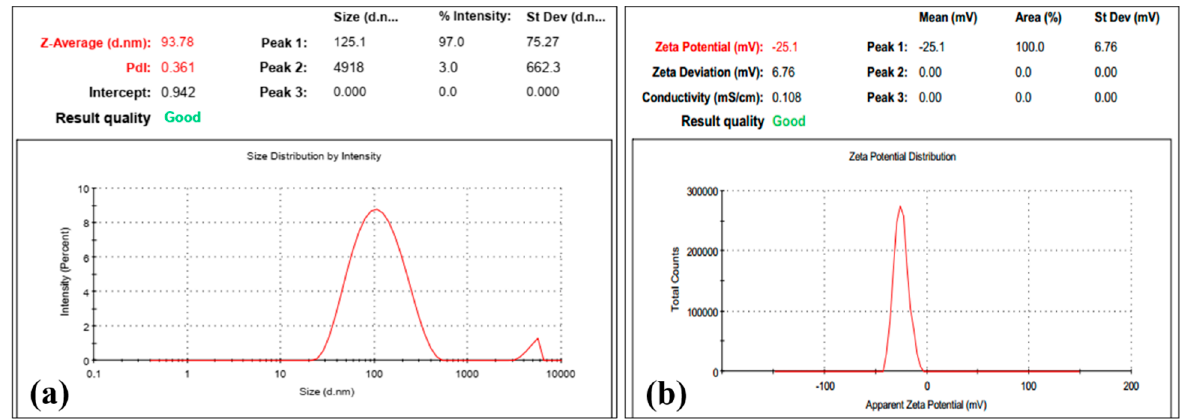
Figure 2. DLS of AgNPs synthesized using T. funiculosus extracts. ( a ) Distribution of the average size. ( b ) Surface charge. ( b ) Surface